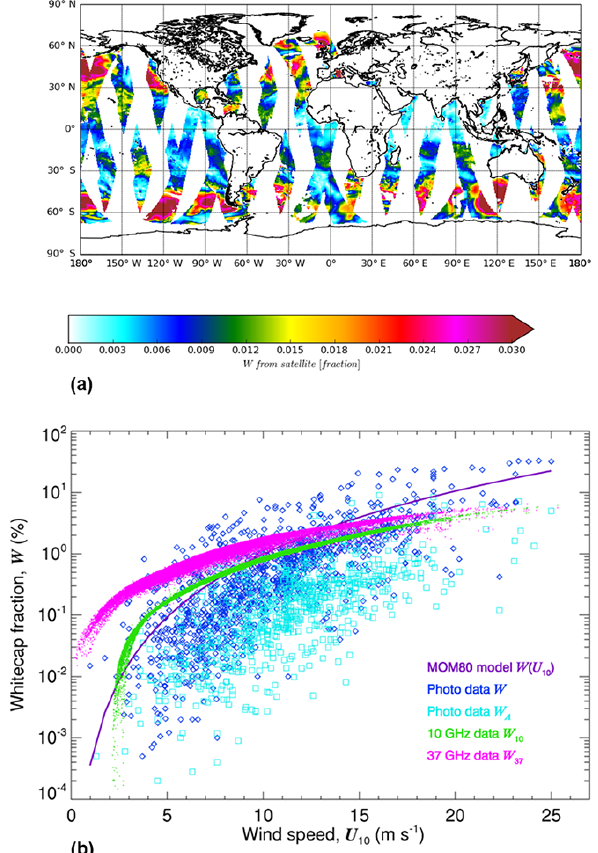
Figure 1. Satellite estimates of W data at 37GHz for 11 March 2006. (a) Map (0.5 ◦ × 0.5 ◦ ) of ascending and descend- ing passes for W at 37GHz; (b) W at 10 and 37GHz (green and magenta symbols, respectively) compared to historical pho- tographic data including total W (diamonds) and active whitecap fraction W A (squares). Parameterization W(U 10 ) of Monahan and O’Muircheartaigh (1980, MOM80) (purple line) is shown for refer-